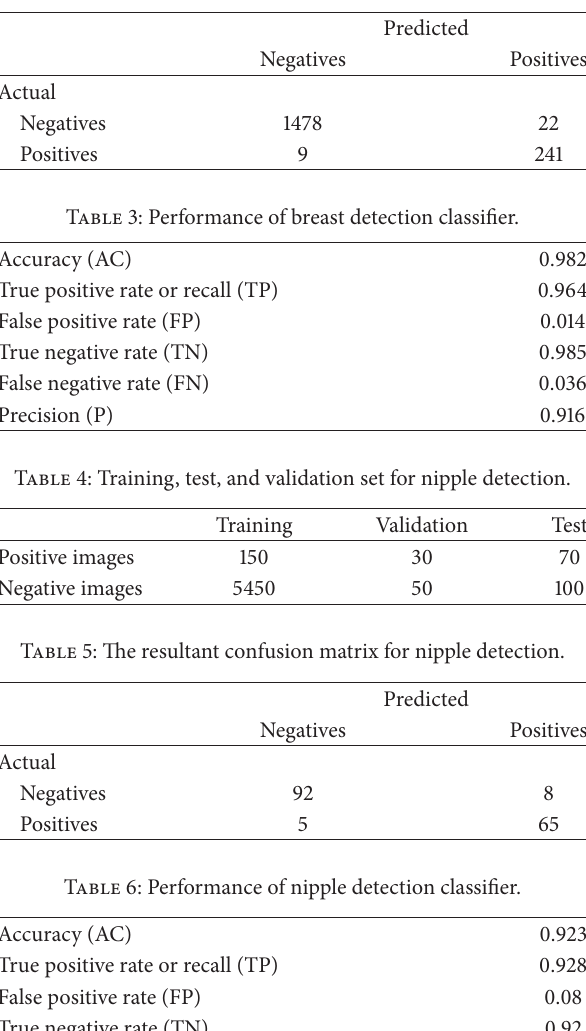
Table 2: The resultant confusion matrix for breast detection.